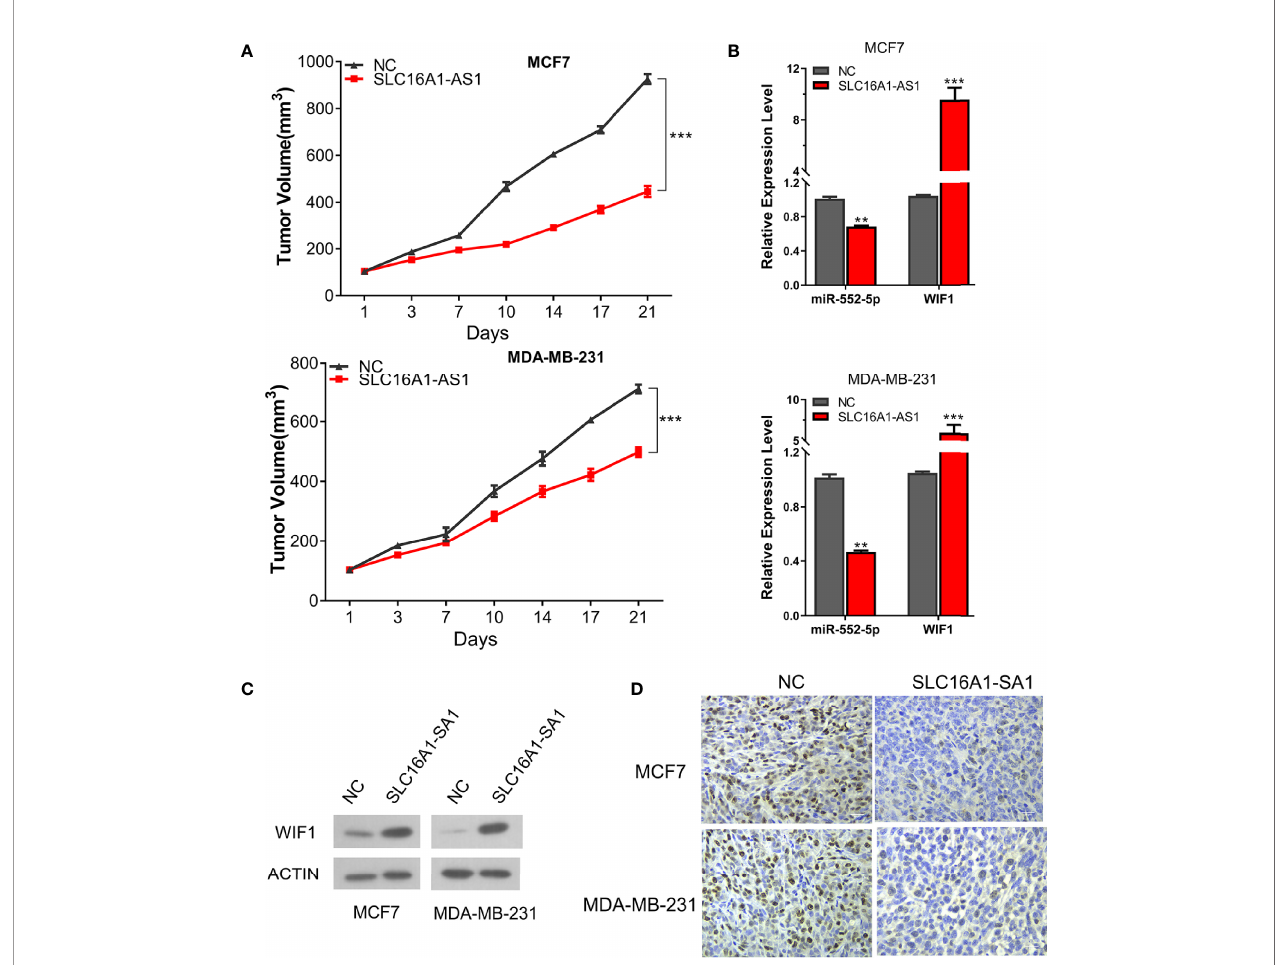
FIGURE 7 | Overexpression of SLC16A1-AS1 in both MCF7 and MDA-MB-231 cells inhibits BC xenograft tumor growth by regulating the miR-552-5p/WIF1 axis in vivo. Xenograft tumor in nude mice was prepared with SLC16A1-AS1 overexpressed (SLC16A1-AS1) or the control (NC) plasmid-transfected MCF7 or MDA-MB- 231 cells, then the following phenotypes were analyzed: (A) growth curve (tumor volume). (B) miR-552-5p and WIF1 mRNA expressions via the qRT-PCR assay. * p < 0.05, ** p < 0.01, *** p < 0.001. (C) WIF1 protein expression via the Western blot assay. (D) Ki-67 protein expression by the immunochemistry